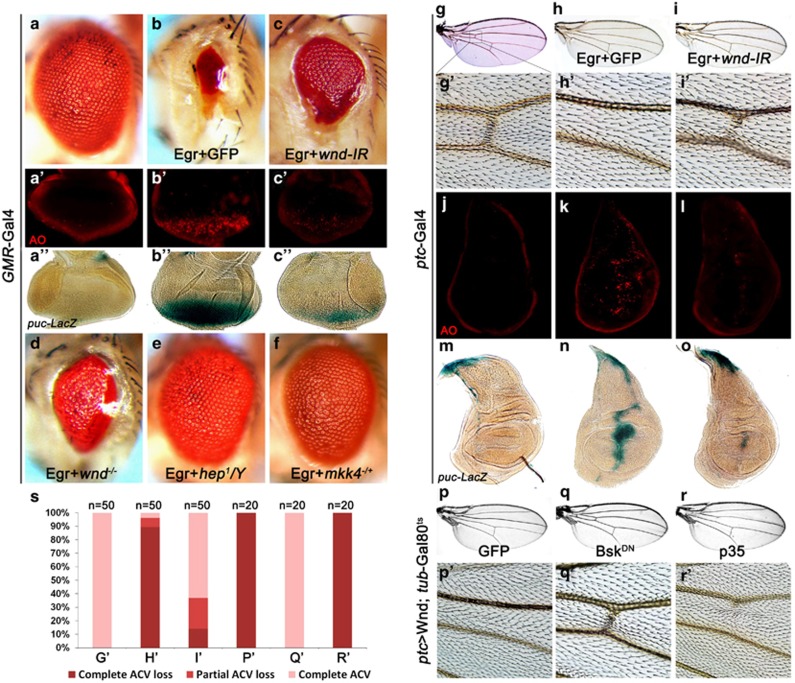
Wnd regulates Egr-induced cell death and JNK activation. (a–f) Compared with the GMR-Gal4 control (a–a”), Egr-induced small-eye phenotype (b), cell death (b') and puc-LacZ expression (b'') were suppressed partially by knocking down wnd (c–c''). The GMR>Egr small-eye phenotype was suppressed partially in wnd mutants (d, wnd1/wnd3), but near fully in hemizygous hep (e, hep1/Y) or heterozygous mkk4 (f, mkk4G673/+) mutants. (g–o) Compared with the ptc-Gal4 control (g, j and m), Egr-triggered cell death (k) and JNK activation (n) in wing discs and the loss of anterior crossvein in adult wings (h and h') were suppressed by knocking down wnd (i, i', l and o). (p–r) Wnd-induced loss of anterior crossvein phenotype (p and p') was completely suppressed by the expression of BskDN (q and q'), but not that of p35 (r and r'). (s) Quantification data of loss of anterior crossvein phenotype in (g', h', i', p', q' and r')